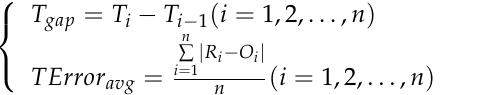
Figure 7. Concurrent stream comparison.